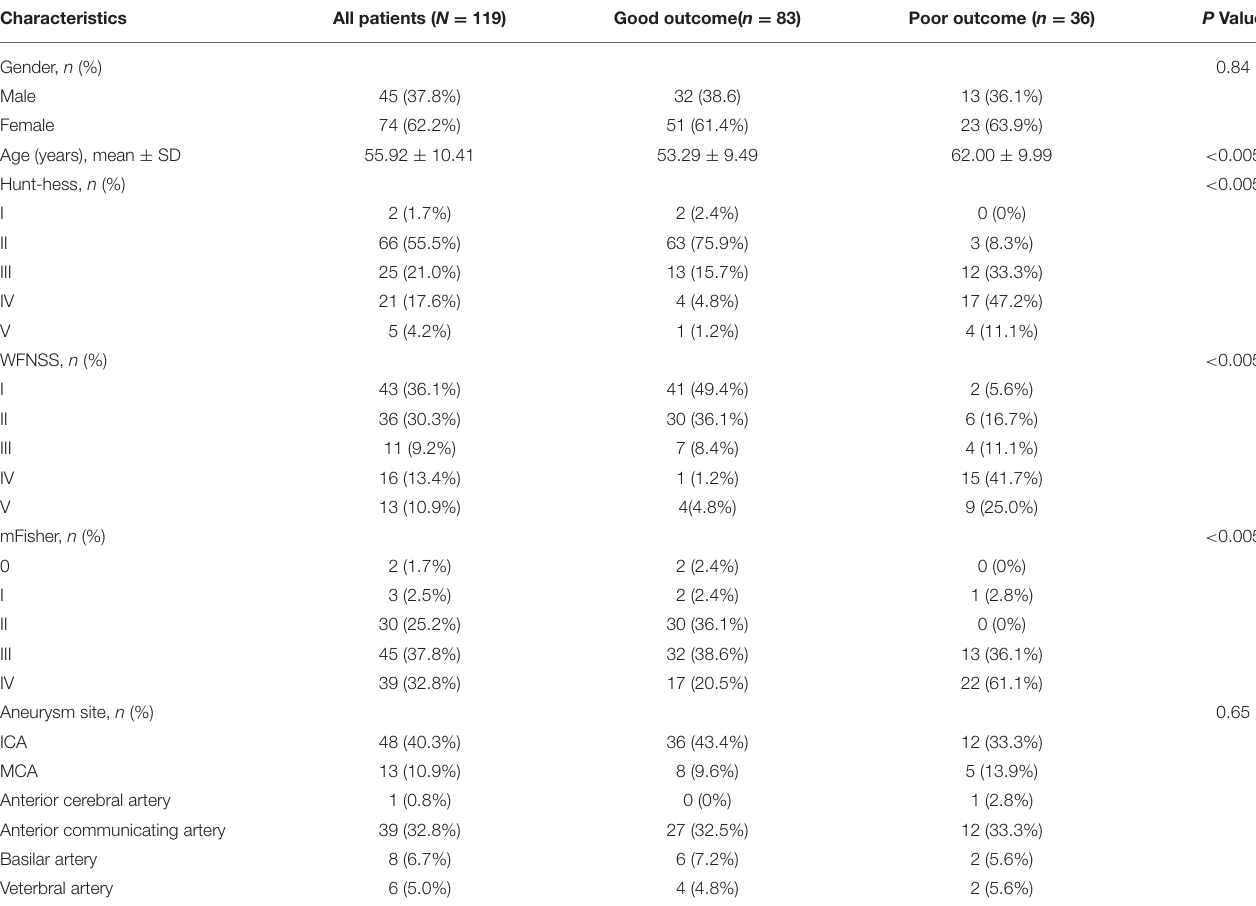
TABLE 1 | Demographics and clinical features of aneurysmal patients with SAH.